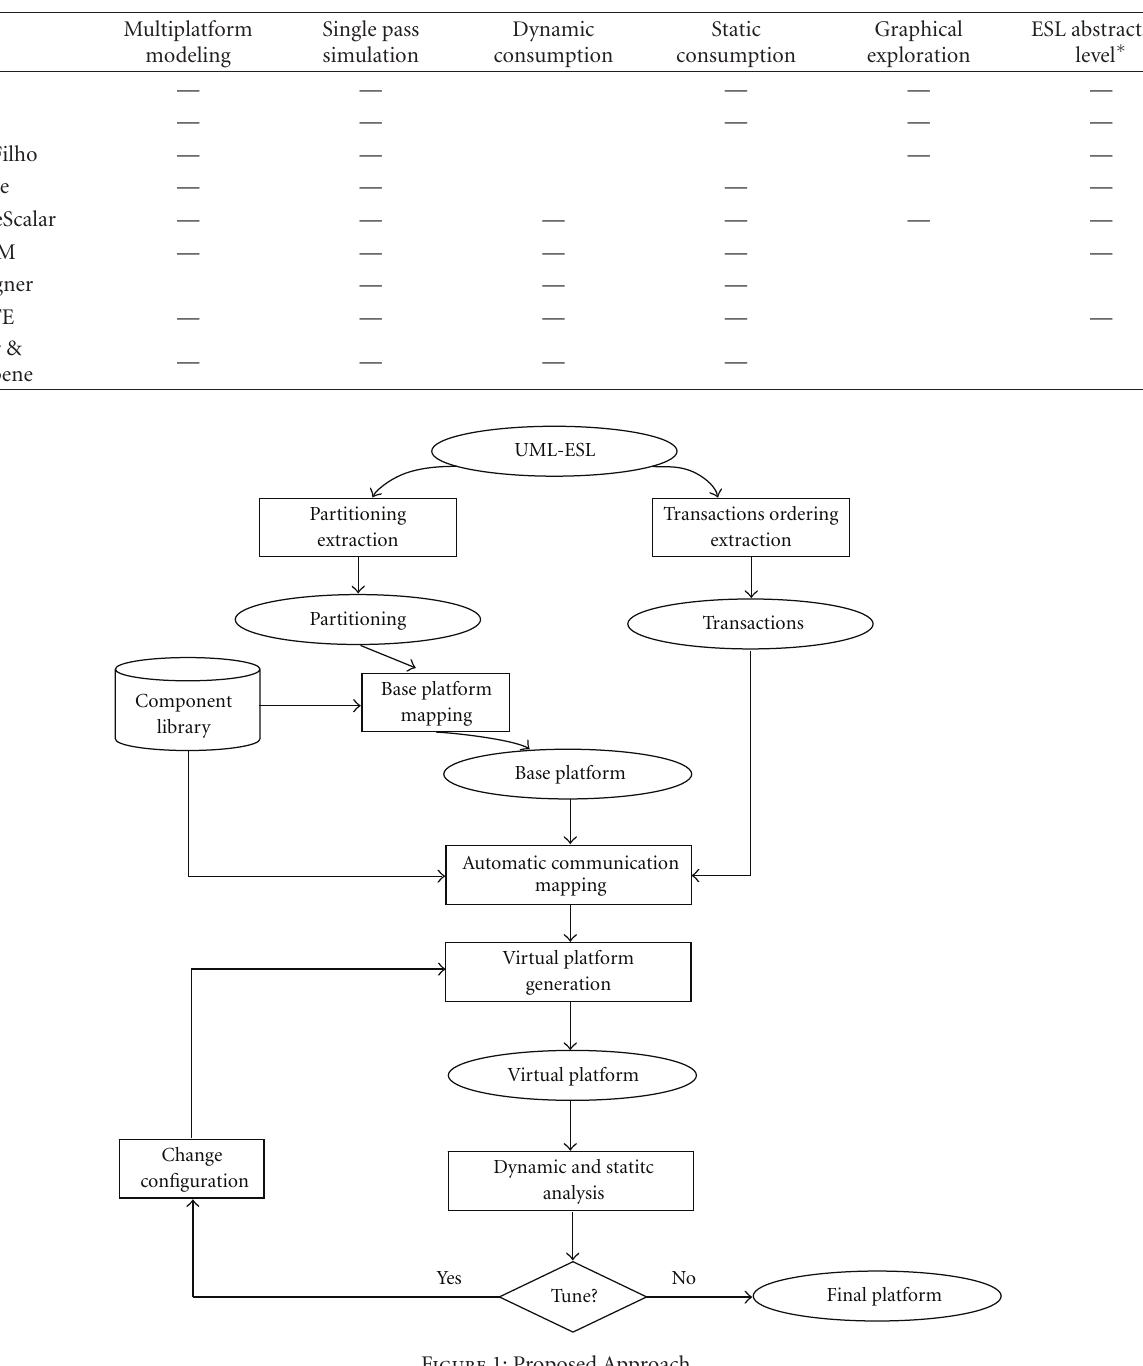
Table 1: Comparison of related studies.